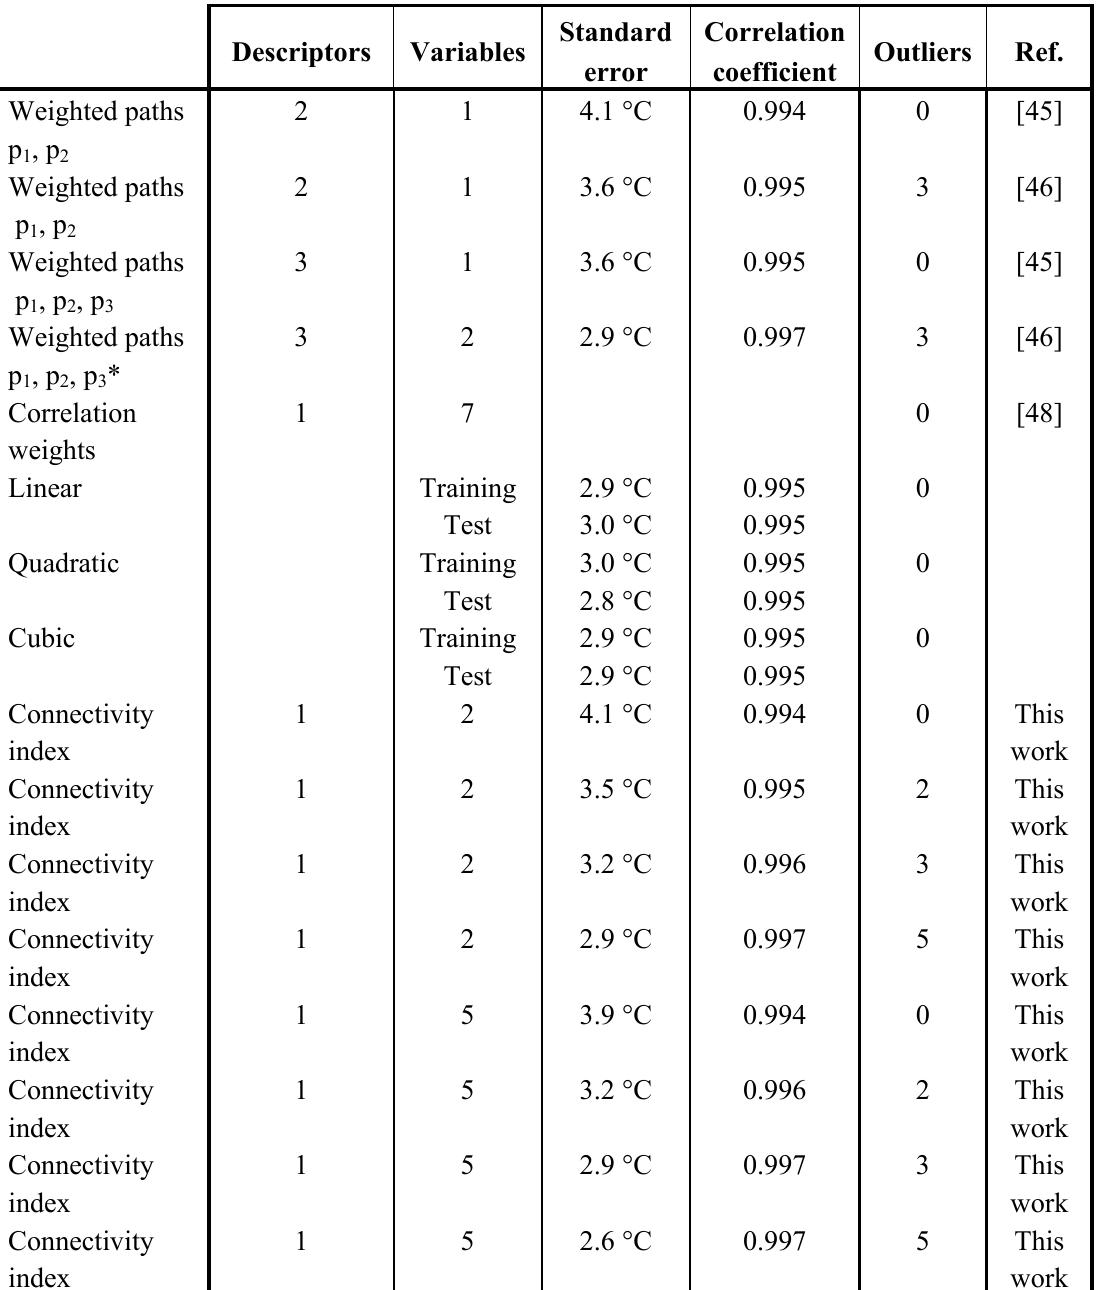
Table 1 . Statistical data on regression of the normal boiling points of alcohols. We grouped data from different sources ending with results from this study Standard Correlation Descriptors Variables Outliers error coefficient